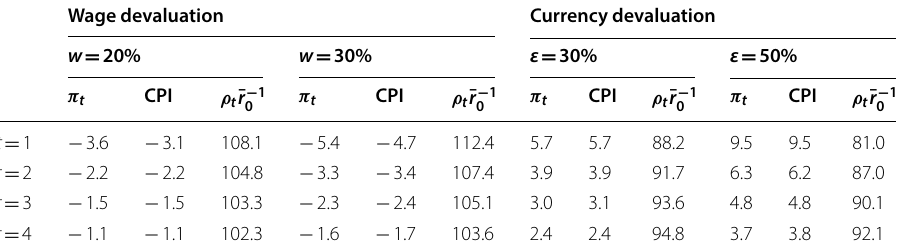
Table 6 The evolution of the average inflation rate, CPI and average real profit rate (%); Greece